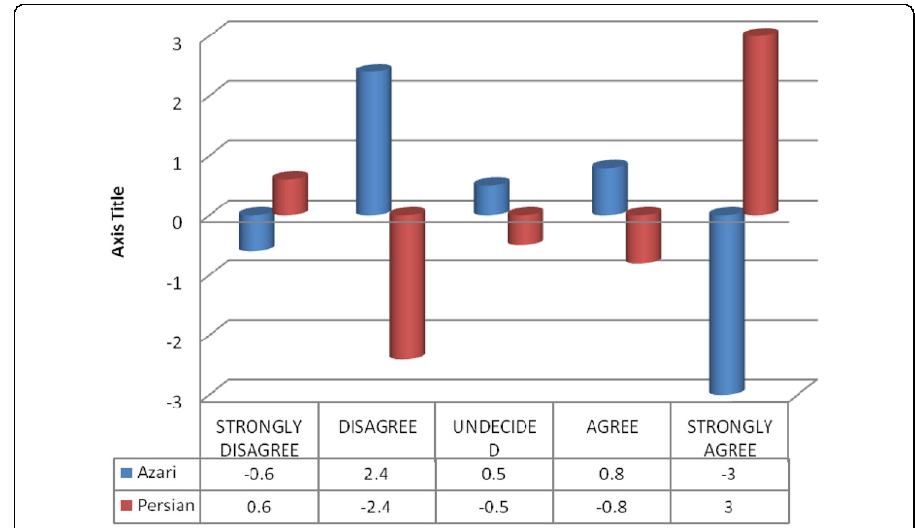
Fig. 2 Standardized residuals of the teachers ’ perceptions towards explicit grammar instruction and corrective feedback